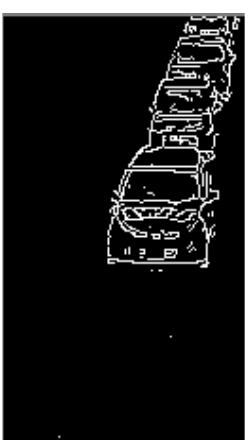
Figure 12. An edge